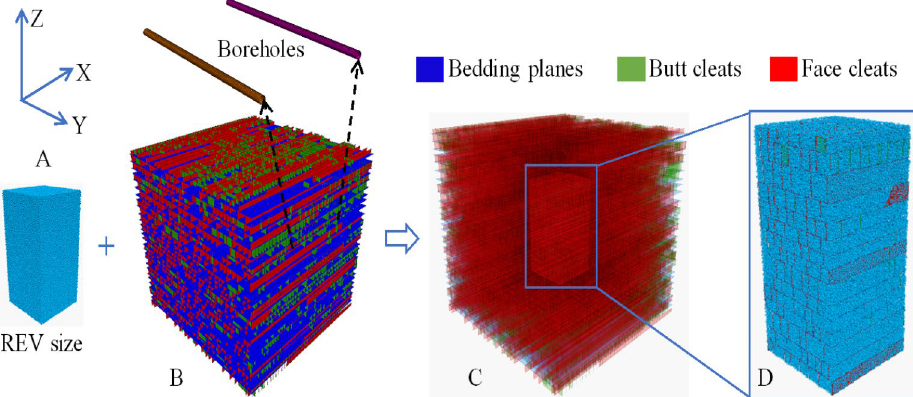
Fig. 2 Construction of